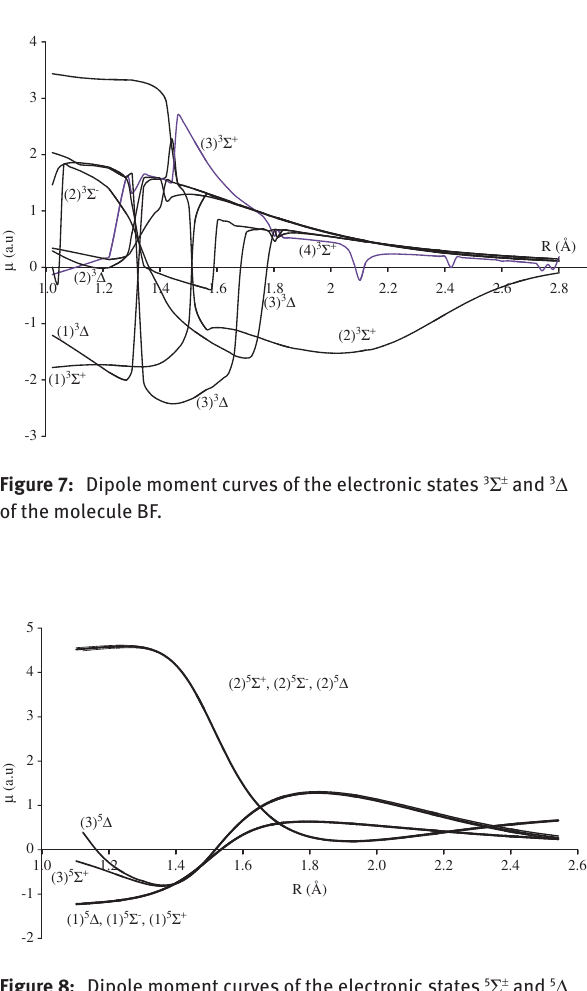
Figure 8: Dipole moment curves of the electronic states 5 Σ ± and 5 Δ of the molecule